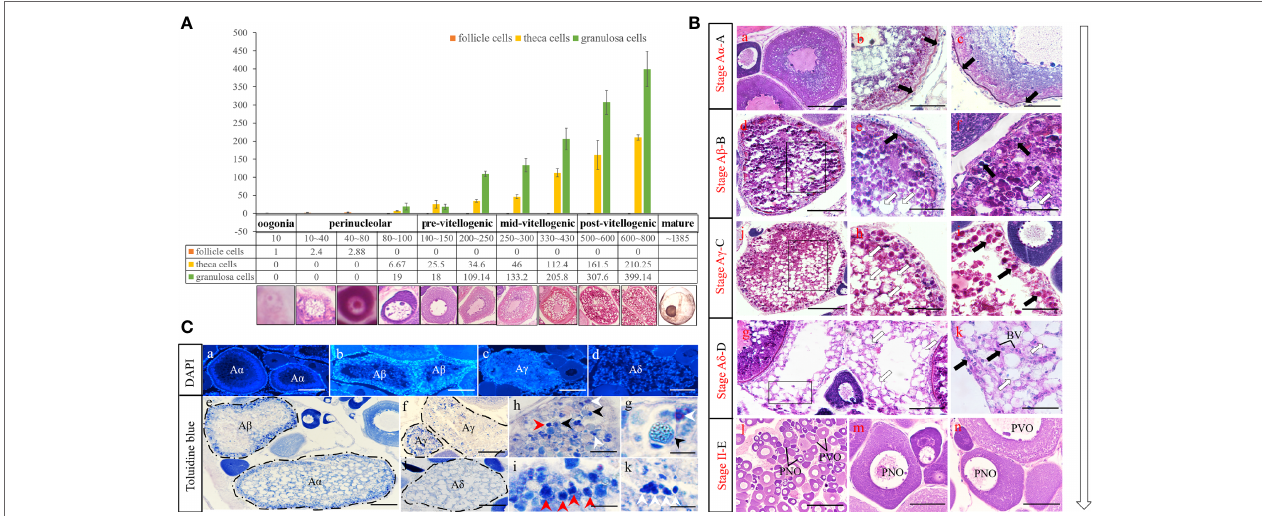
FIGURE 1 | Statistic and morphological analysis of oogenesis and follicle atresia. (A) The number of somatic cells, and morphology and diameter of different germ cell from oogonia to mature egg stages of P. argenteus. (B) Five stages of P. argenteus follicle atresia collected for histological and RNA-seq analysis. White and black arrows indicate phagocytic vacuoles and somatic cells respectively. Scale bar = 200 μm (a, g, n), 150 μm (b, c, e), 250 μm (d, j, m), 100 μm (f, h, i, k), and 600 μm (l). (C) Histological identification of nucleus and immune cells stained by DAPI and Toluidine blue, respectively. White, black, and red arrows indicate mast cells, macrophages, and leucocytes, respectively. Scale bar = 300 μm (a), 200 μm (b, c, d), 400 μm (e, f, j), 35 μm (h), 20 μm (i, k), and 15 μm